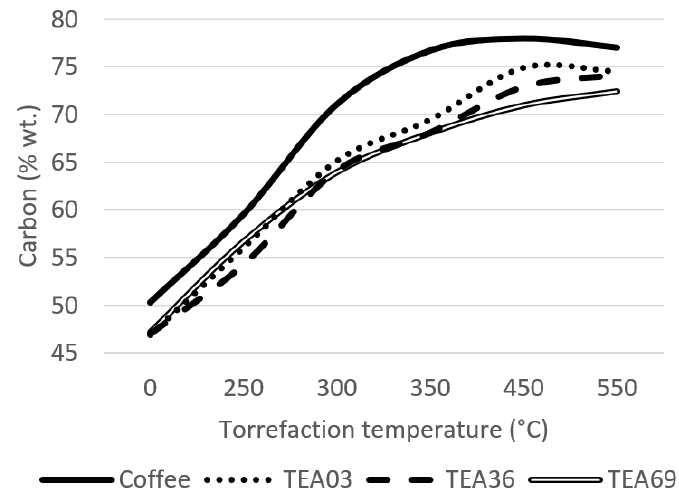
Figure 2. Carbon share of the material.